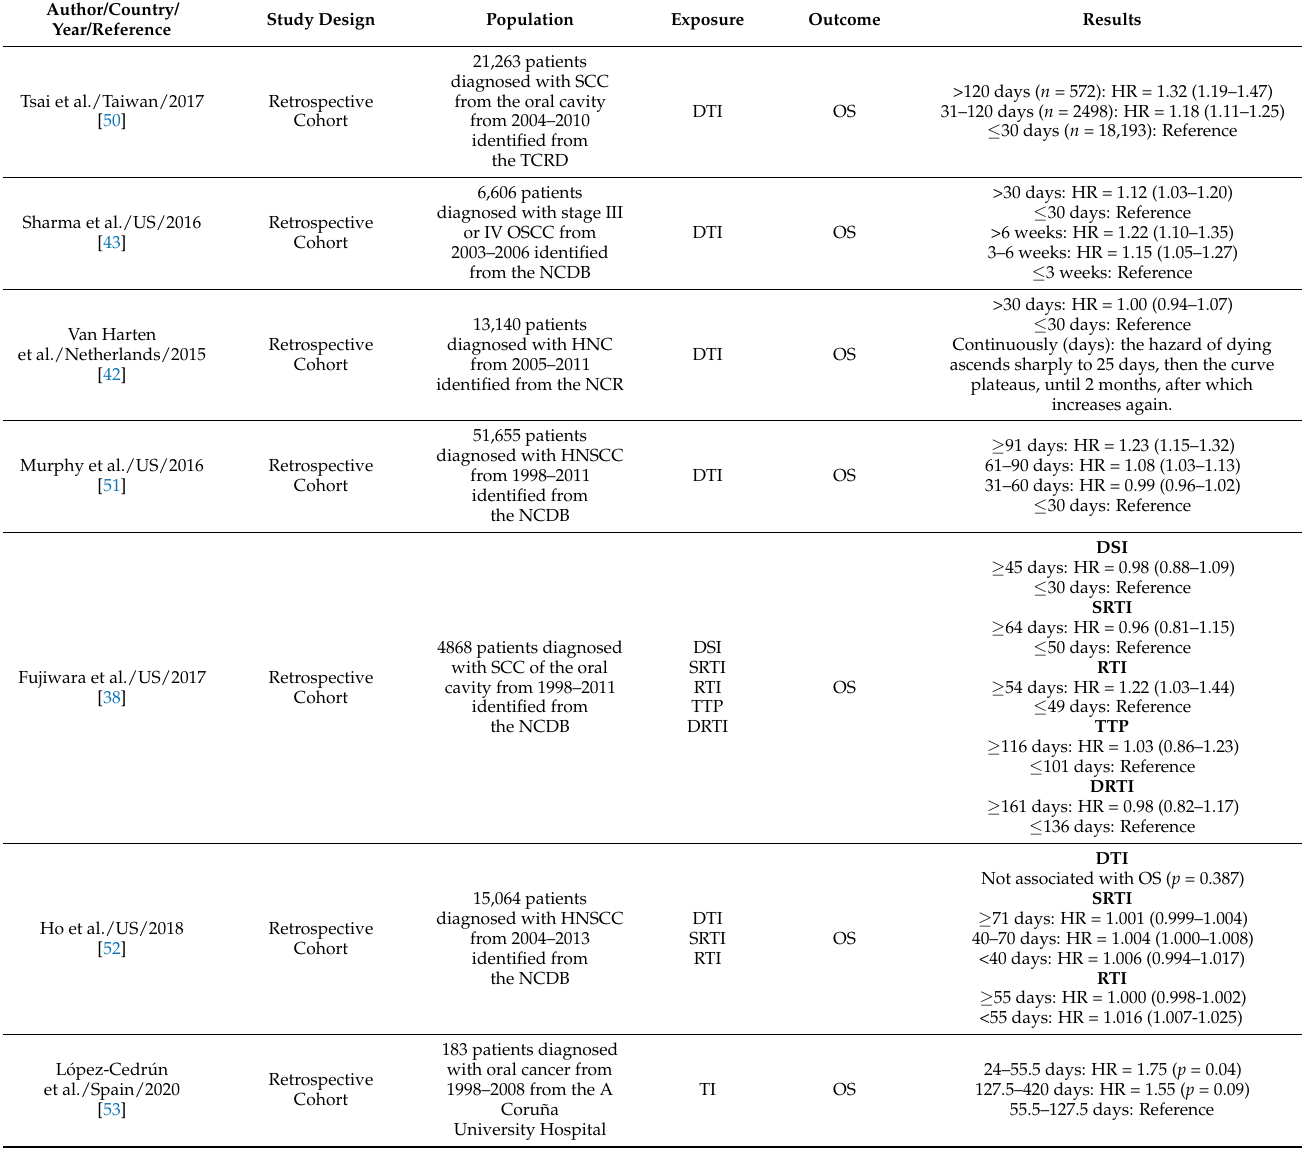
Table 2. Studies assessing the impact of pre-treatment and treatment intervals on survival from head and neck